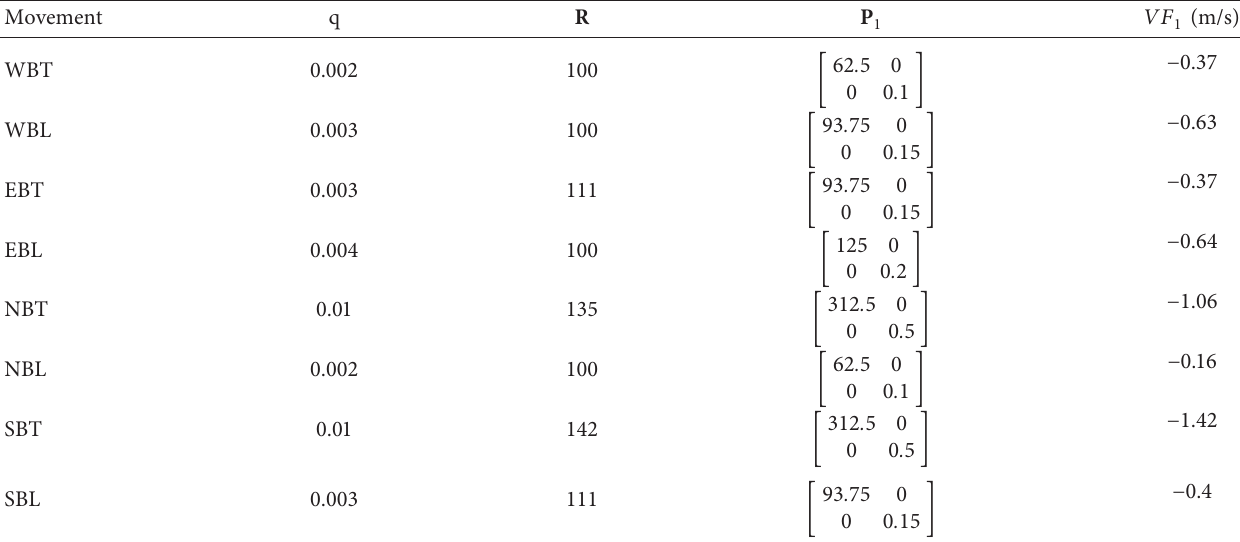
Table 2: Parameters for the case